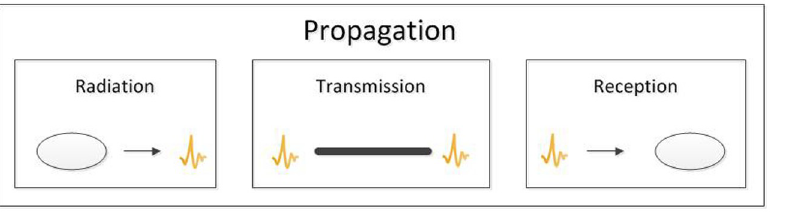
Fig 1. Propagation is composed of three distinct sub-processes; Radiation refers to the process with which an actor translates a change in state into an outgoing signal, Transmission to the process by which this signal is transferred (via a tie) towards the alter(s), and Reception to the process by which alters respond to the incoming signal and may change state